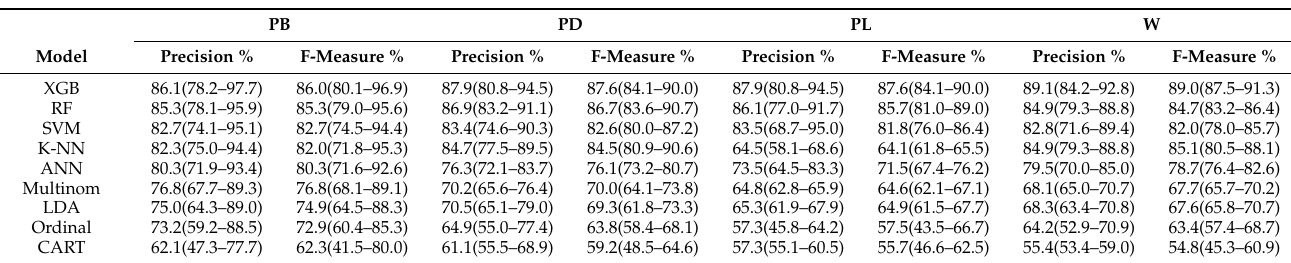
Model: (XGB: Gradient boosting decision tree model, RF: random forest, K-NN: k-nearest neighbors, SVM: support vector machines, ANN: neural networks, multinorm: multinomial regression, LDA: linear discriminant analysis, Ordinal: ordinal logistic regression, CART: classification and regression